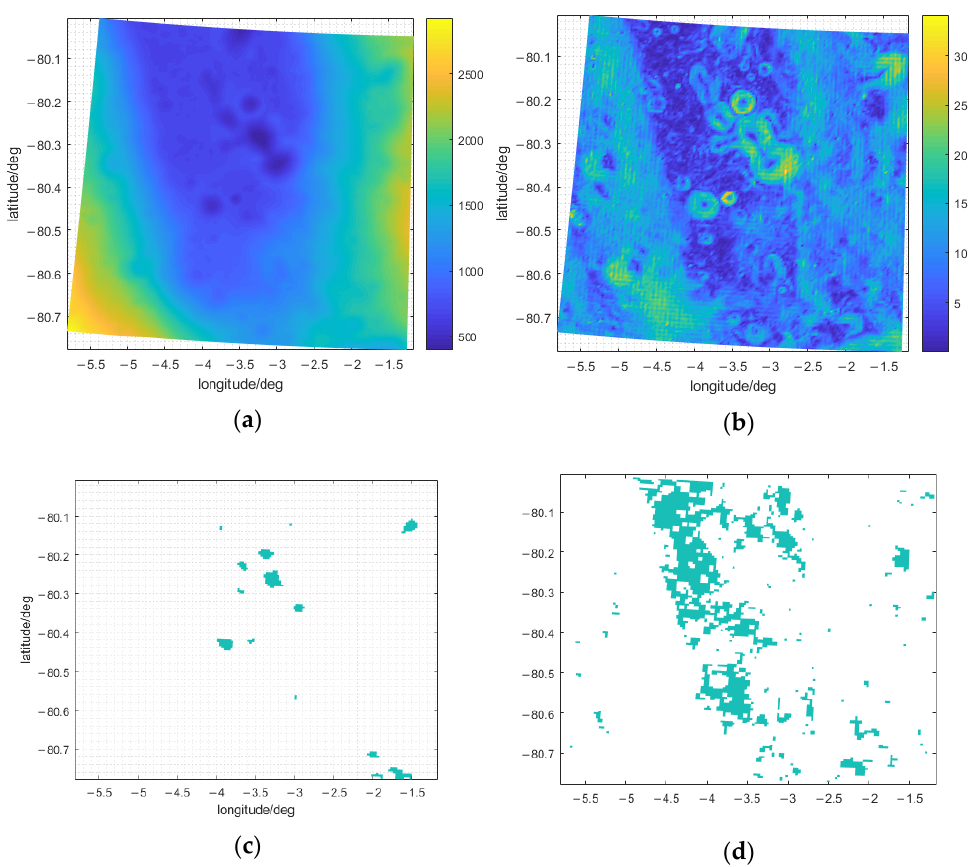
Figure 10. The distribution of ( a ) DEM, ( b ) slope, ( c ) permanent shadow area and ( d ) area with slope constraint of the partial area centered in Malapert A.